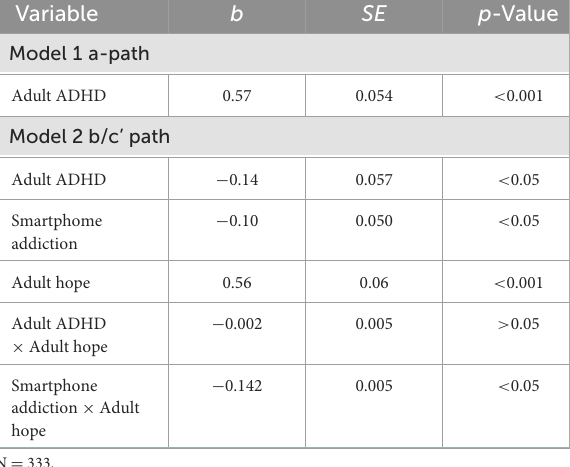
explains 32% of the variance of wellbeing ( R 2 = 0.317). TABLE 5 Regression results for the a-path from adult ADHD to smartphone addiction, path b from smartphone addiction to wellbeing, and path c’ from adult ADHD to